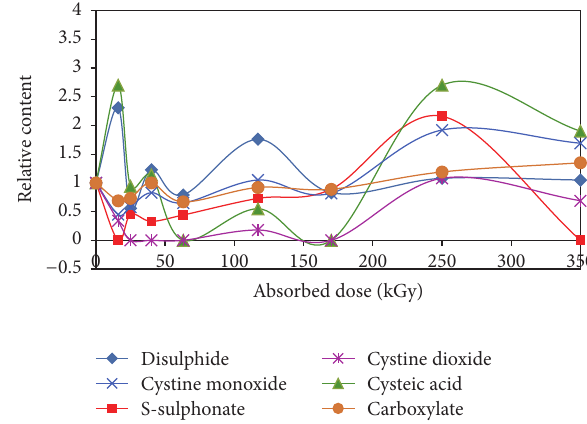
Figure 1: Variation of relative content in disulphides, S-sulfonate, cysteic acid, cystine monoxide, cystine dioxide, and carboxylates in the wool with absorbed dose 4 days after electron beam irradiation.